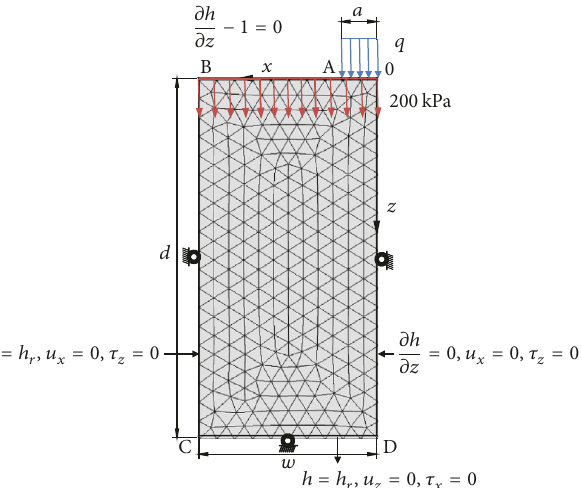
Figure 2: The symmetric two-dimensional model and the finite element mesh used in the computational modelling.